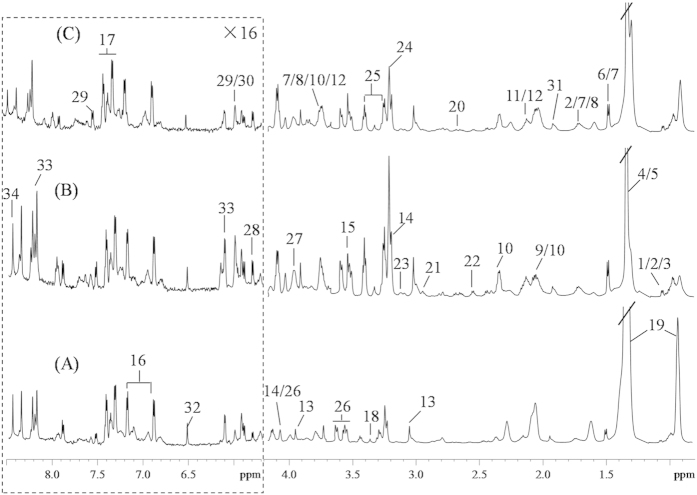
Average 600 MHz 1H HRMAS NMR spectra of ANIT (A), stage I CRC tumor (B) and stage IV CRC tumor (C). The region of δ 5.7–8.5 was vertically expanded 16 times compared with δ 0.8–4.2. Metabolite keys: 1, isoleucine; 2, leucine; 3, valine; 4, lactate; 5, threonine; 6, alanine; 7, lysine; 8, arginine; 9, proline; 10, glutamate; 11, methionine; 12, glutamine; 13, creatine; 14, choline; 15, glycine; 16, tyrosine; 17, phenylalanine; 18, scyllo-inositol; 19, lipid; 20, aspartate; 21, asparagine; 22, glutathione; 23, cysteine; 24, phosphorylcholine/glycerophosphocholine; 25, taurine; 26, myo-inositol; 27, phosphoethanolamine; 28, uracil; 29, cytosine; 30, isocytosine; 31, acetate; 32, fumarate; 33, inosine; 34, formate.